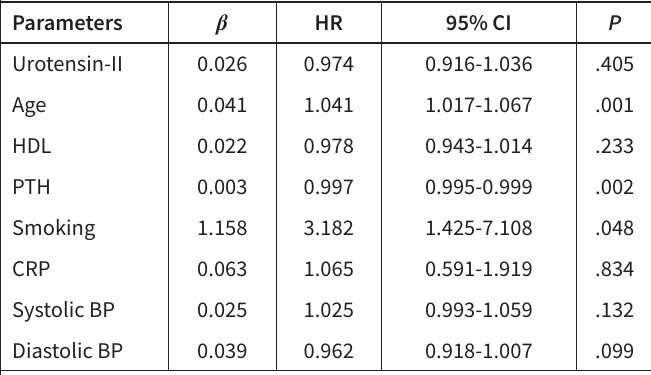
Table 4. Multivariate Cox Regression Analysis of the Parameters Affecting the Presence of